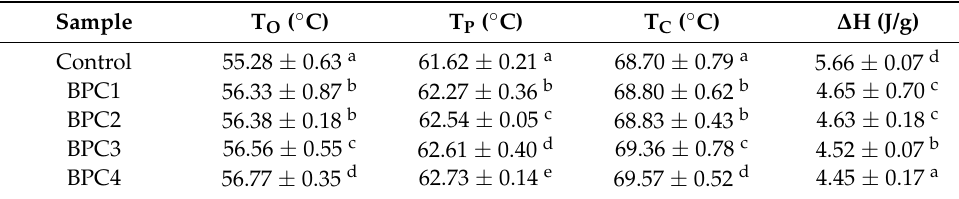
Table 1. Thermal properties of wheat– P. curatellifolia composite flours. Sample